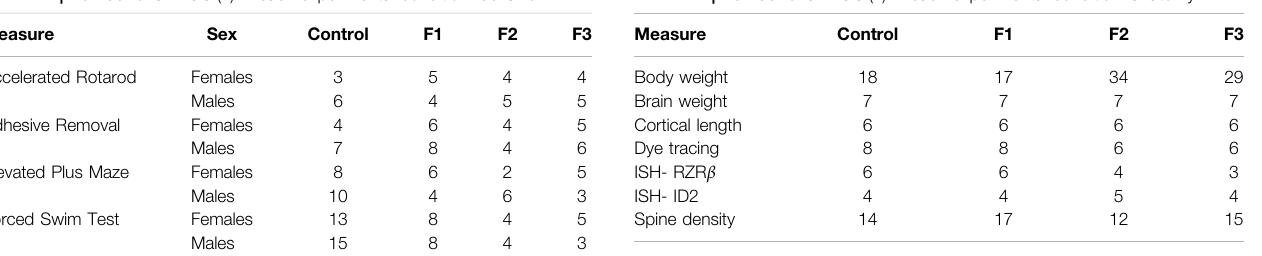
TABLE 2 | Number of animals (n) in each experimental condition: